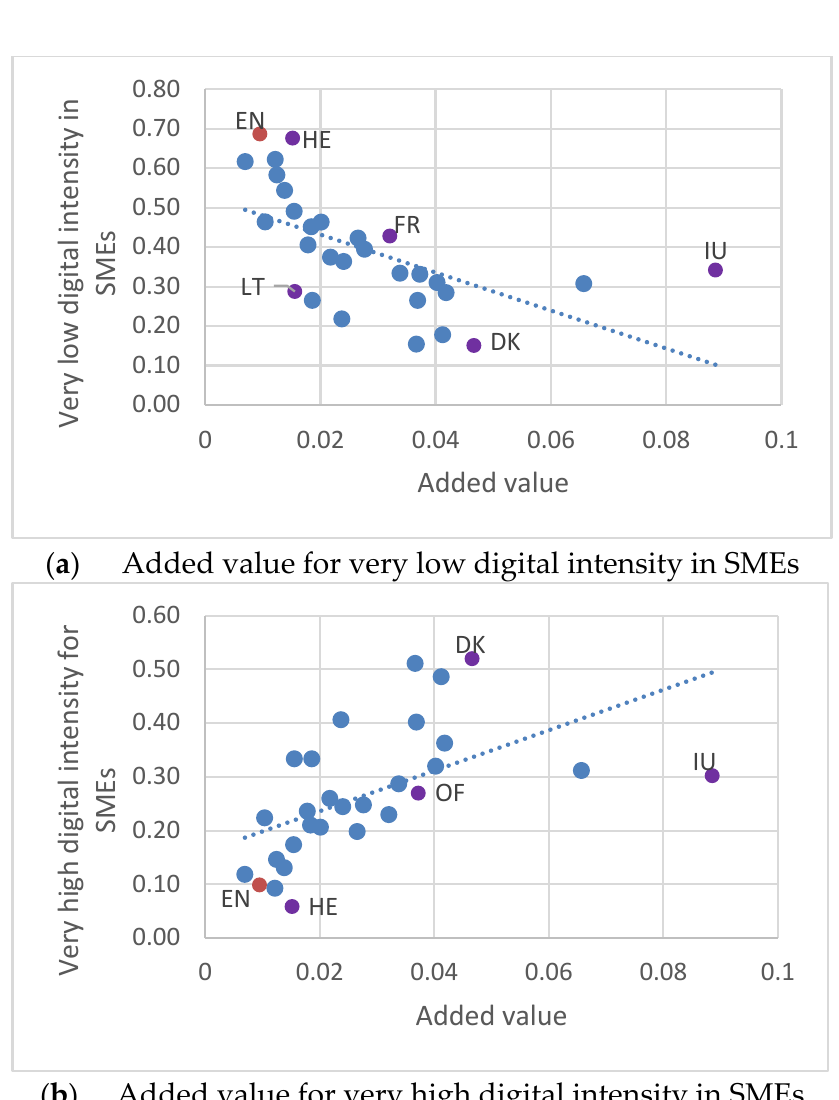
Figure 4. The relationship between digital integration and the EU added value in 2019.